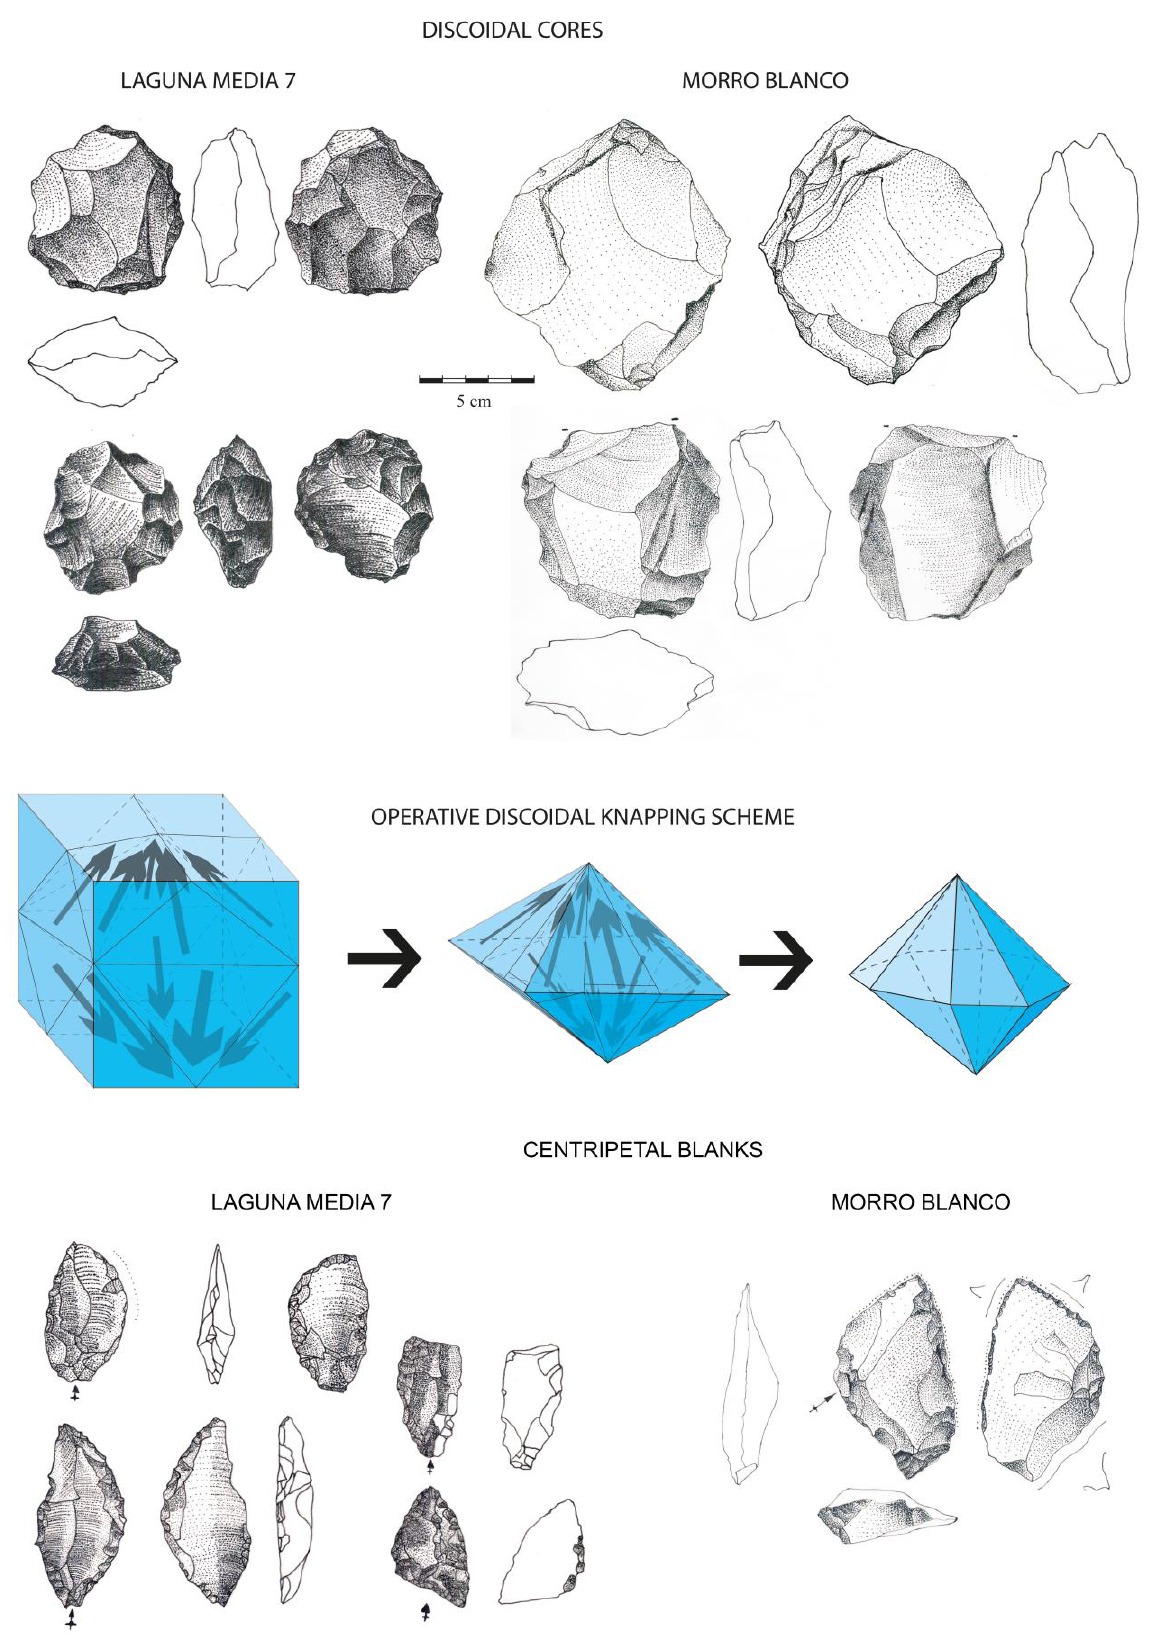
Figure 10. Discoidal operative schemes and centripetal